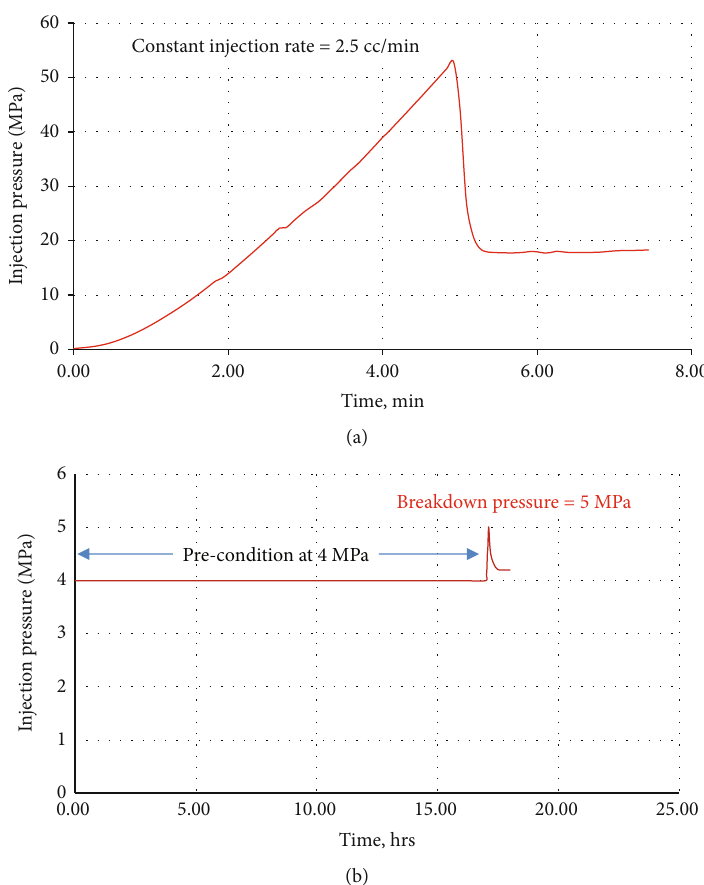
Figure 7: Injection pressure response in samples B9 (a) and B7 (b) during the hydraulic injection